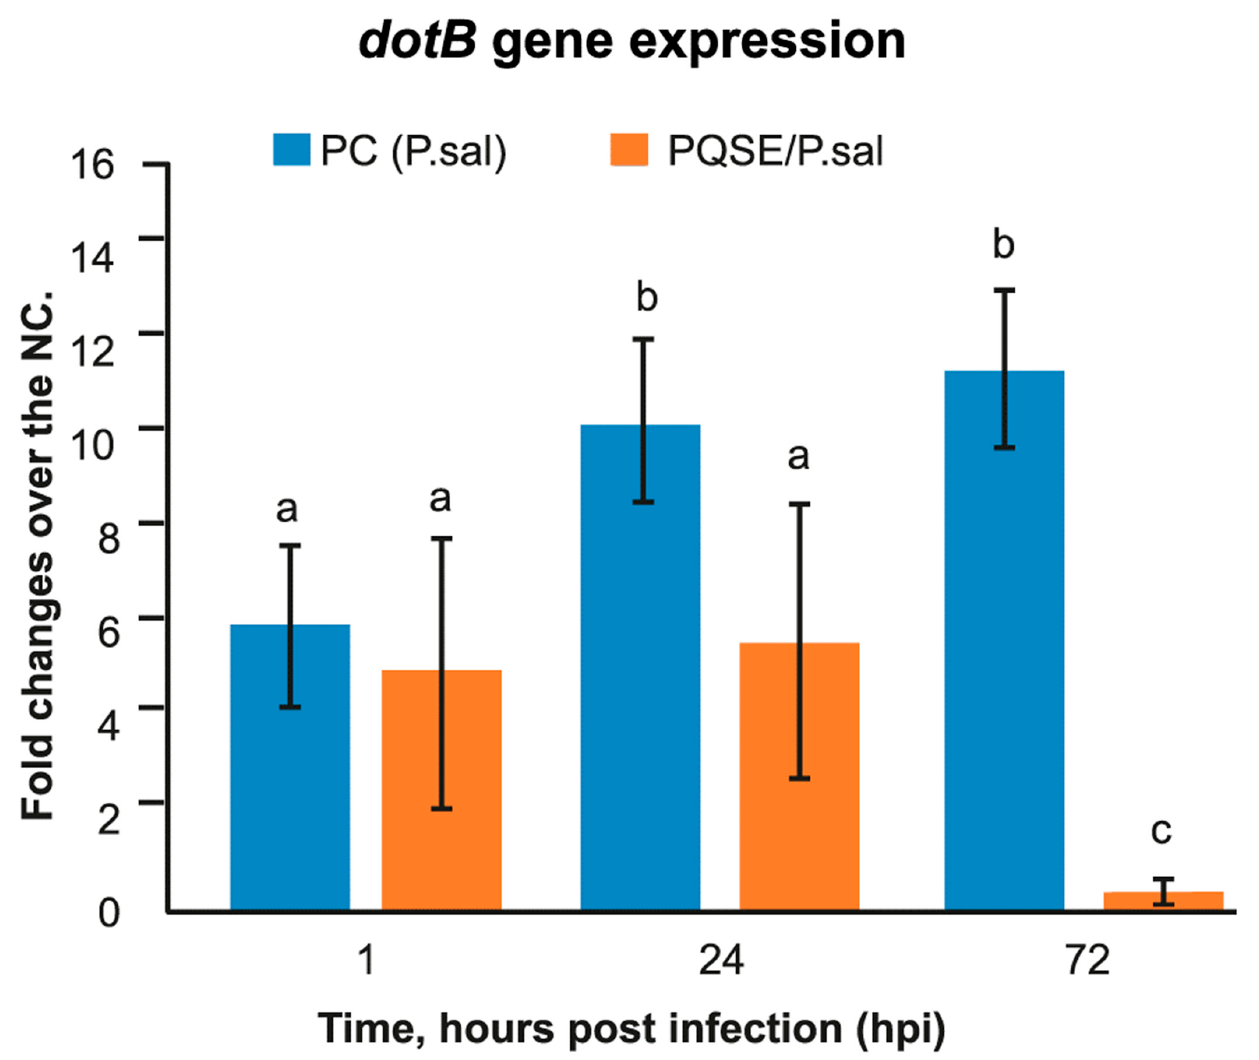
Figure 5. Gene expression analysis of dotB (T4-BSS) in SHK1 cells pre-incubated with 0.5 µ g/mL of Quillaja extract (PQSE) and challenged with P. salmonis . dotB gene expression at 1, 2 and 72 hpi in cells pre-incubated with PQSE. Results are expressed as fold change relative to Negative Control (NC), as average values of triplicate determinations. SHK-1 cells pre-incubated with PQSE for 4 h, prior to a challenge with P. salmonis , significantly reduce ( p < 0.05) the gene expression of the virulence factor dotB , compared to the Positive Control (PC: P. salmonis ), at 24 and 72 hpi. NC: Negative Control (without PQSE and without P. salmonis ); PC: Positive Control ( P. salmonis ) PQSE+ P.sal : SHK-1 cells pre-incubated with PQSE and then challenged with P. salmonis . Different letters, a, b and c depict statistically significant differences according to the Mann-Whitney test ( p < 0.05)